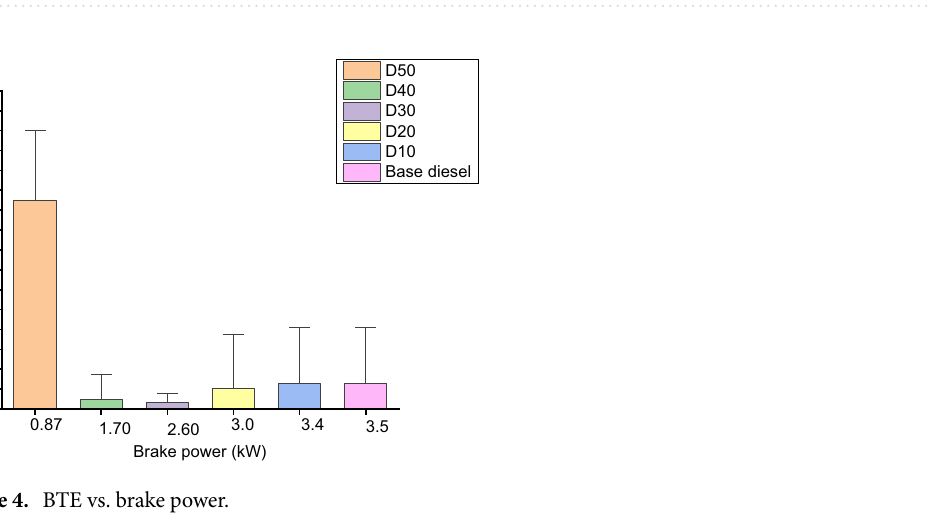
Table 1. Test engine specification.